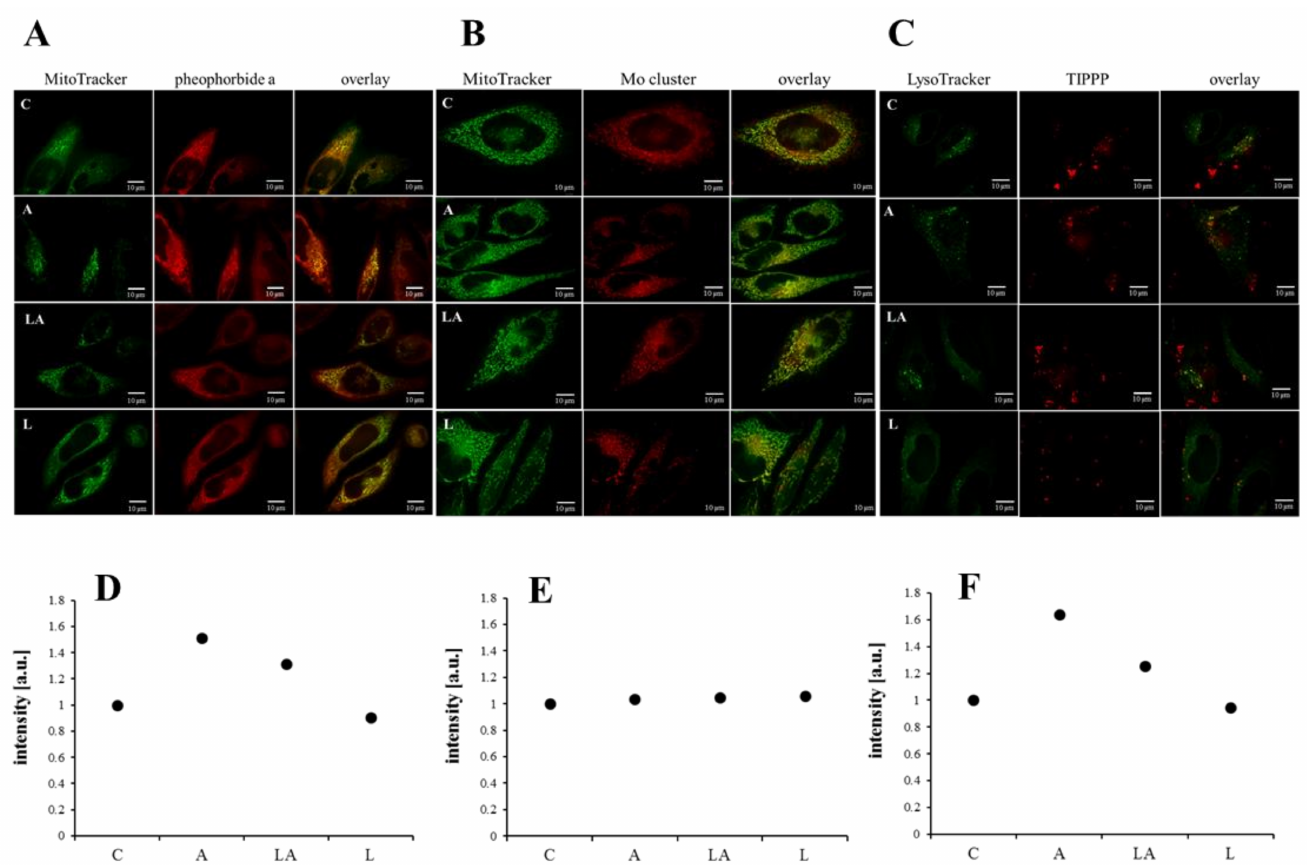
Figure 4. The effect of lactic acidosis on uptake and localization of photosensitizers in cancer cells. Localization of ( A ) pheophorbide a , ( B ) Mo cluster, and ( C ) 5,10,15,20-tetrakis(4-isopropylphosphinatophenyl)porphyrin (TIPPP) in HeLa cells treated with the experimental media for 72 h. The photosensitizers (red emission) were co-localized with ( A , B ) MitoTracker TM Green FM or ( C ) LysoTracker TM Green DND-26 (both green emission) to visualize the subcellular localization. Uptake of ( D) pheophorbide a , ( E ) Mo cluster, and ( F ) TIPPP in PaTu-8902 cells treated with the experimental media for 72 h measured by flow cytometry. C, control; A, acidosis; LA, lactic acidosis; L, high